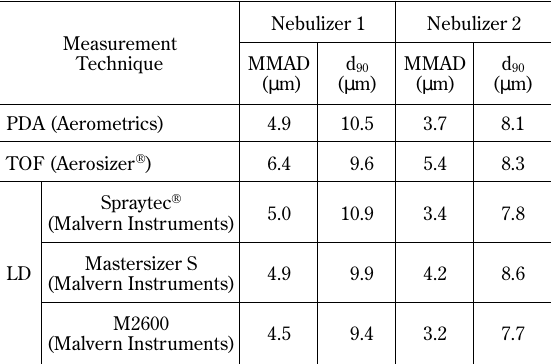
Percentile of the Volume-Weighted Distribution (d 90 ) for Aqueous Droplets Produced by Two Jet Nebulizers (from [50]: Reprinted from J. Aerosol Sci . 31(1), Corcoran, T.E., Hitron, R., Humphrey, W. and Chigier, N., ‘Optical measurement of nebulizer sprays: A quantitative com- parison of diffraction, phase Doppler interferometry, and time-of-flight techniques”, 35-50., Copyright (2000), with permission from